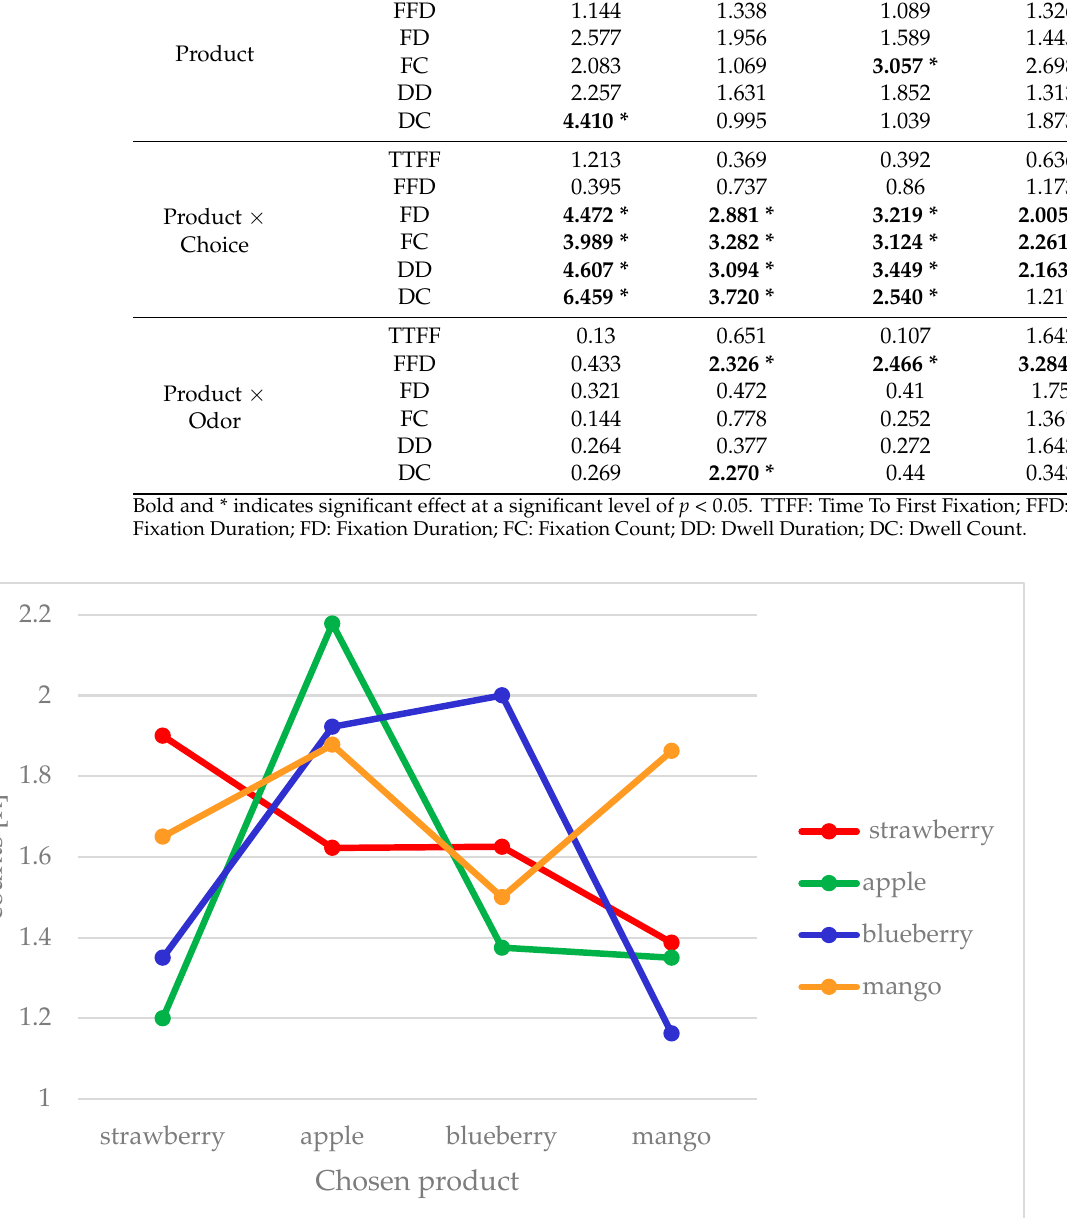
Figure 4. First fixation durations between the odor and odorless conditions for the yoghurt product group. The length of the first fixation did not influence other eye-tracker parameters, so no higher values were recorded for FD, FC, DD and DC when the strawberry odor was pre- sent. However, the choice frequency of products was partially influenced by the odor in the case of chocolates ( χ 2 = (3,6) = 13.675, p < 0.05) and yoghurts ( χ 2 = (3,6) = 110,077,703, p < 0.001). For chocolate products, strawberry-, raspberry- and Oreo-flavored alternatives received higher choice frequencies when the odor was present, while the peanut-flavored alternative was chosen less frequently. For yoghurts, participants chose strawberry- and blueberry-flavored alternatives with a higher frequency under the odor condition. Tea